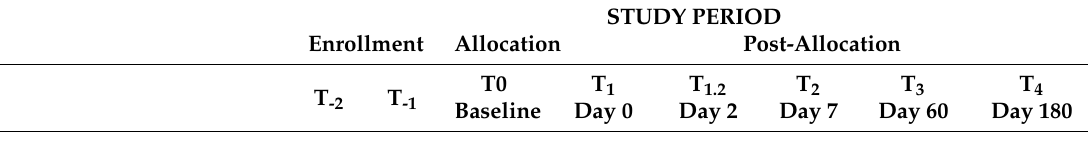
Table 3. Participant timeline showing time schedule of enrollment, interventions and assessments of participants. Abbreviations: BMI—Body Mass Index, IPAQ-SF—International Physical Activity Questionnaire Short Form, FEGK—Questionnaire for the Collection of Health-Related Control Beliefs, VAS—Visual Analog